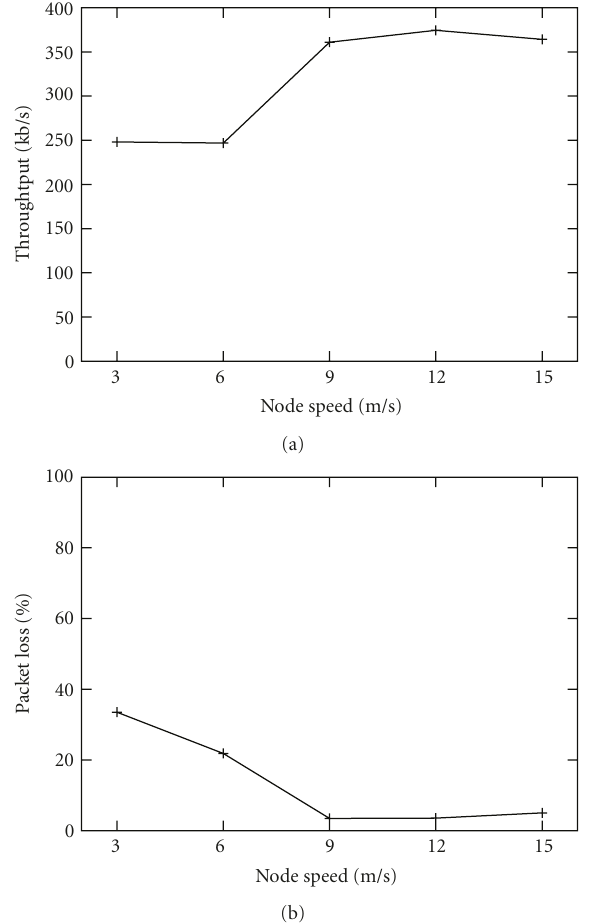
Figure 29: Throughput and packet losses with a movie in a scenario with